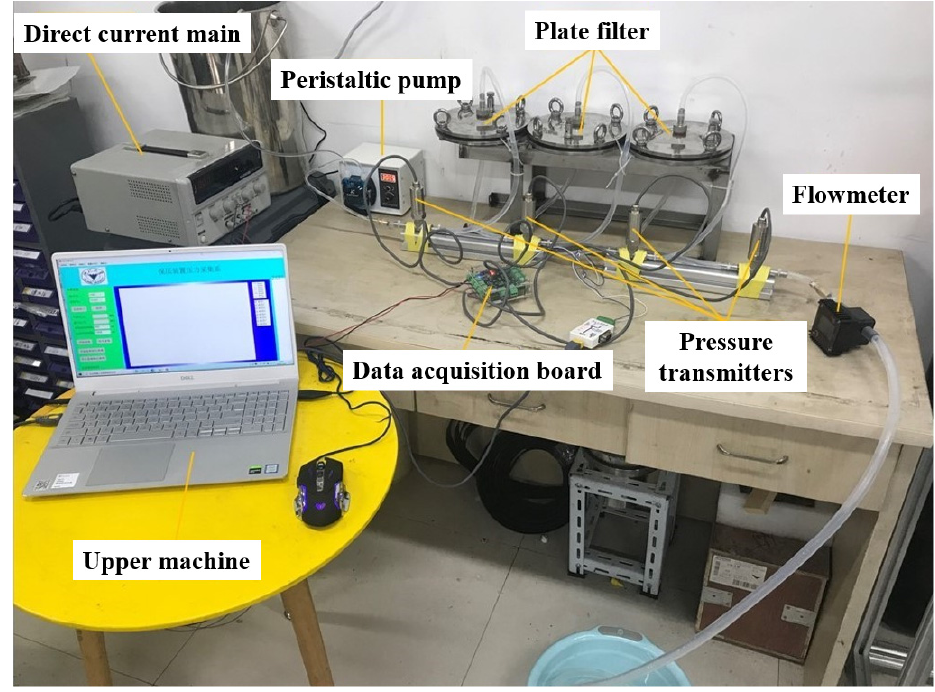
Figure 10. Material diagram of multi-stage membrane separation and filtering test system.